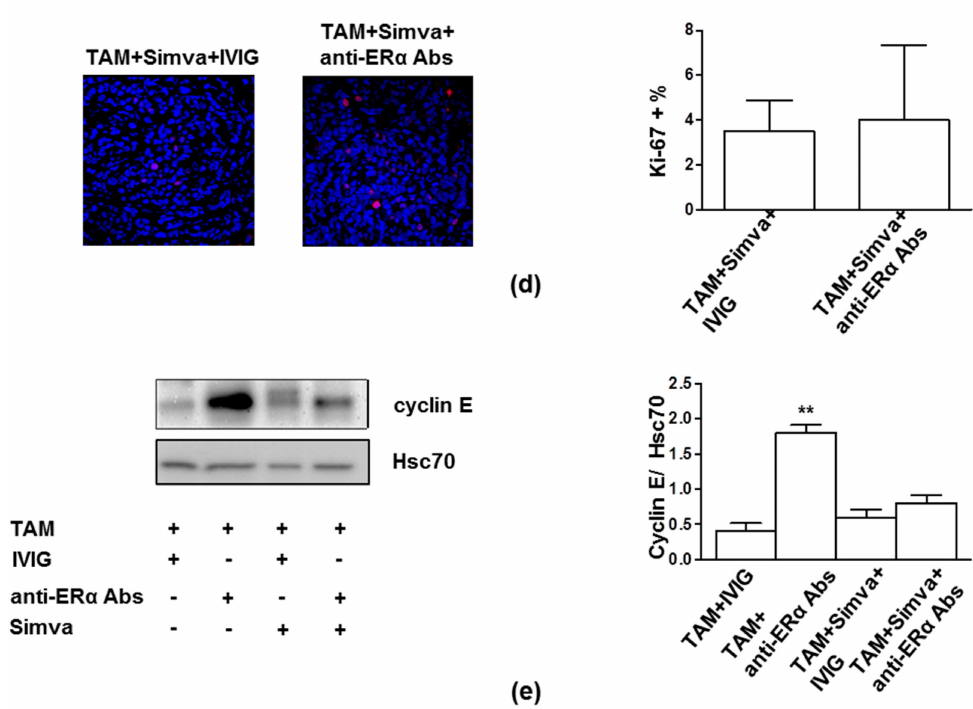
Figure 4. Simvastatin treatment, blocking anti-ER α Abs action, restored TAM e ff ect both in vitro and in vivo. ( a ) Cell proliferation was evaluated by flow cytometry measuring Ki-67 nuclear antigen expression in MCF-7 cells treated for 24 h with TAM (1 µ M) in combination with (i) IVIG (50 µ g / mL); (ii) anti-ER α Abs (50 µ g / mL); (iii) IVIG (50 µ g / mL) plus simvastatin (2.5 µ M); (iv) anti-ER α Abs (50 µ g / mL) plus simvastatin (2.5 µ M). Data are reported as mean ± SD of five independent experiments. TAM plus anti-ER α Abs vs. each other condition, *, p < 0.05 by Student’s t test. ( b ) Cell-cycle phases were determined by flow cytometry analysis of BrdU / 7AAD staining in synchronized MCF-7 cells treated as reported in panel a. Data are reported as mean ± SD of each phase of five independent experiments. TAM plus anti-ER α Abs vs. each other condition for G0 / G1 phase **, p < 0.01 by Student’s t test. ( c ) The mean ( ± SD) of the tumor volume of one set of experiment (five mice / group) was shown. The tumor volumes were calculated using the following formula: (a × b2) / 2, where a and b represent the longest and shortest diameters, respectively. At day 14, TAM plus anti-ER α Abs vs. each other condition, ***, p < 0.001 by Student’s t test. ( d ) Representative sections from MCF-7 tumors treated with TAM + IVIG + Simva and TAM + anti-ER α Abs + Simva, immunostained with anti-Ki67 (red) antibodies and counterstained with Hoechst (blue) are shown. Ki-67 was scored by the average method as reported in Methods. Results are also represented as mean ± SD. Scale bar = 50 µ m. ( e ) Western blot analysis of cyclin E in tumor lysates. For each cell line, blots shown are representative of five independent experiments (left). Densitometry analysis of specific protein levels relative to Hsc70 is also shown (right). Values are expressed as mean ± SD; TAM plus anti-ER α Abs vs. each other condition, **, p < 0.01 by Student’s t test. Simva: